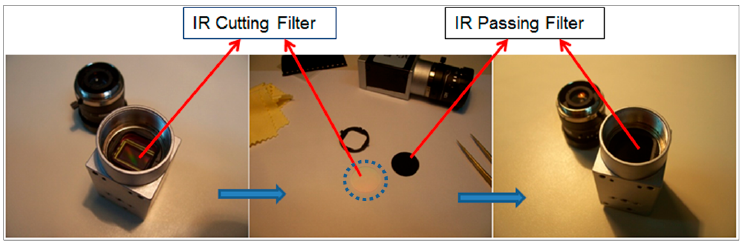
Figure 3. Filter modification of Basler acA2000-340kc camera.